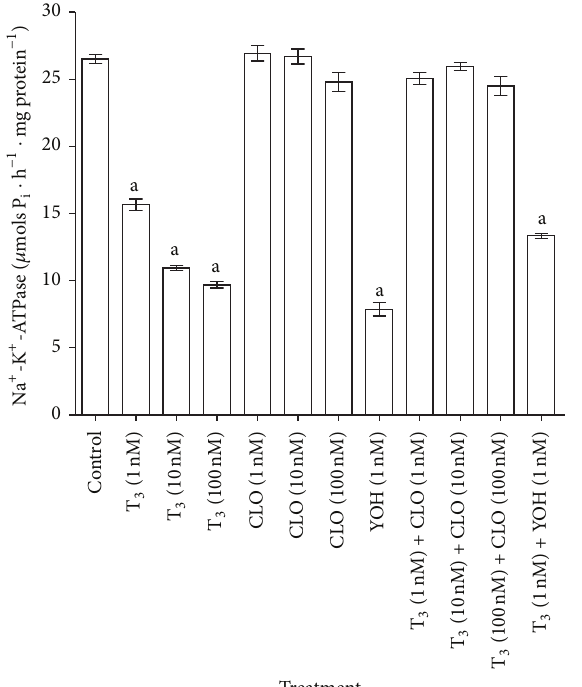
Figure 6: Modulatory effect of glutamate on T 3 -induced inhibition of synaptosomal Na + -K + -ATPase activity in cerebral cortex, in vitro . A higher dose of T 3 (10nM) was chosen from the T 3 dose-response curve, considering its greater inhibitory action on the Na + -K + - ATPase activity and to observe the effect of 100 𝜇 M glutamate on this T 3 -induced inhibition. The data are represented as mean ± SEM of four separate experiments taking six animals in each group. a 𝑃 < 0.001 , compared to the control group (one-way ANOVA followed by Newman-Keuls